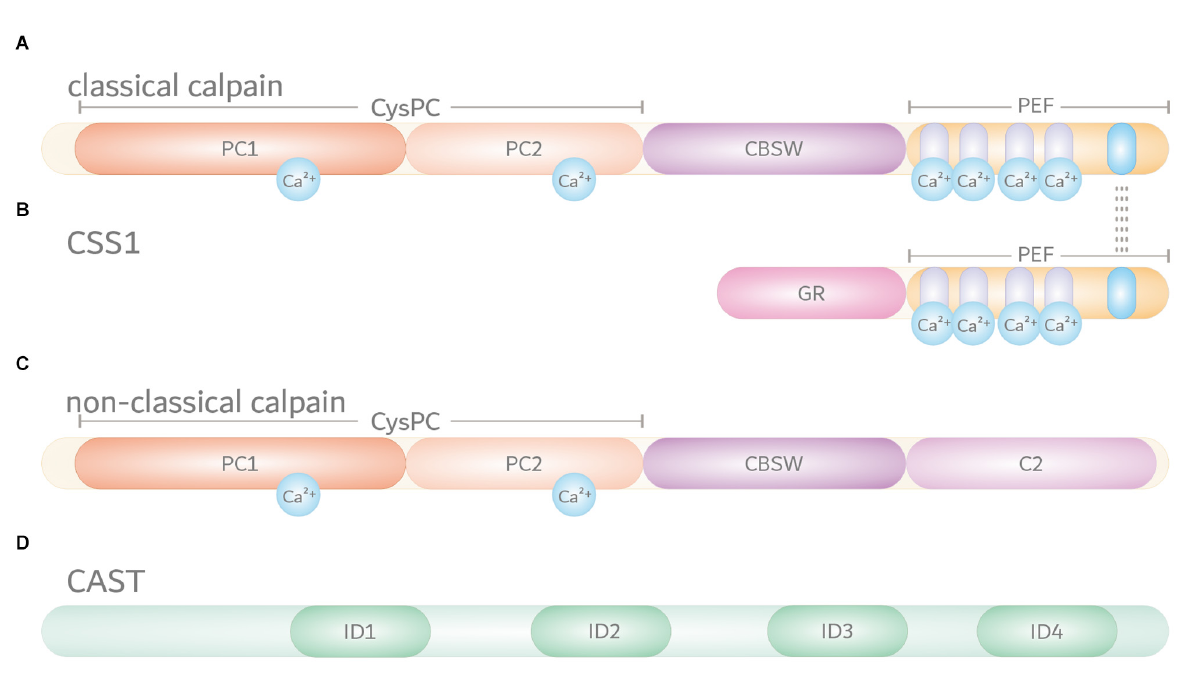
FIGURE1 Domain composition of the members of the intracellular calpain system. Based on their domain composition, calpains are divided into two main groups. (A) Classical calpains, including the conventional calpains calpain-1 and calpain-2, are characterized by a proteolytically active CysPc domain harboring two core domains PC1 and PC2. In addition, classical calpains comprise a calpain-type β -sandwich (CBSW) domain and a C-terminal calcium-binding penta-EF-hand (PEF) domain, through which they form inactive stable heterodimers with the regulatory calpain small subunit 1 (CSS1). Individual EF-hand motifs within the PEF domain are illustrated by light purple- and blue-shaded ovals. Interaction with CSS1 via the fifth EF-hand motif is highlighted by dashed lines. Binding of calcium ions (Ca 2+ ) in their respective numbers along the protein structure is indicated by cyan-colored circles. (B) The CSS1 consists of a glycine-rich region (GR) and a PEF domain through which interaction with conventional calpains occurs. (C) Non-classical calpains come in a variety of structural and domain compositions. Aside from sharing the CysPc domain as a common trait, most of them comprise a CBSW domain and, for example, a C-terminal C2 domain. (D) Endogenous calpain inhibitor calpastatin (CAST) contains four repetitive inhibitory domains (ID) that bind to CysPc and PEF domains in calpains, thereby inhibiting their proteolytic